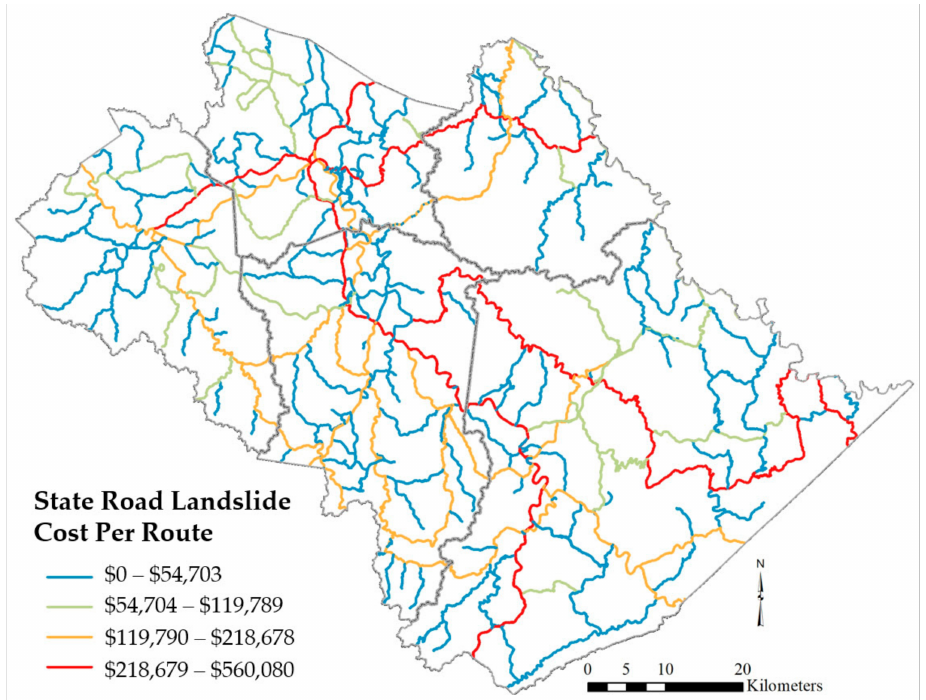
Figure 3. Landslide and rockfall costs per state route in the Big Sandy Area Development District, eastern Kentucky, USA. Costs are in U.S. dollars from 2003 to 2009. Map generated from data in